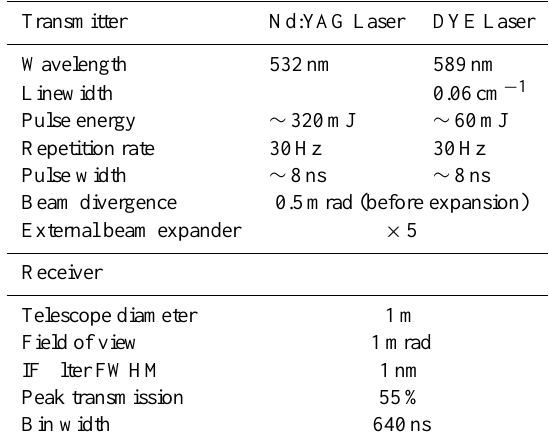
Table 1. The main specifications of the Meridional Project Yanqing lidar.